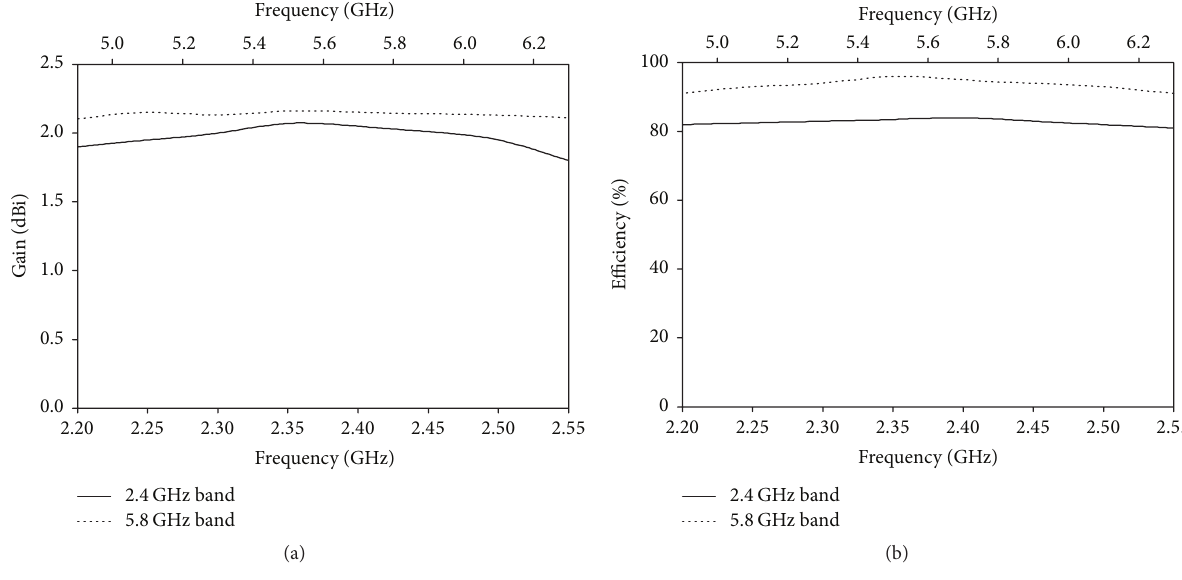
Figure 12: Measured radiation performance of the proposed antenna. (a) Gain. (b) Efficiency. Table 2: Performance comparison of the proposed antenna with other antennas in the